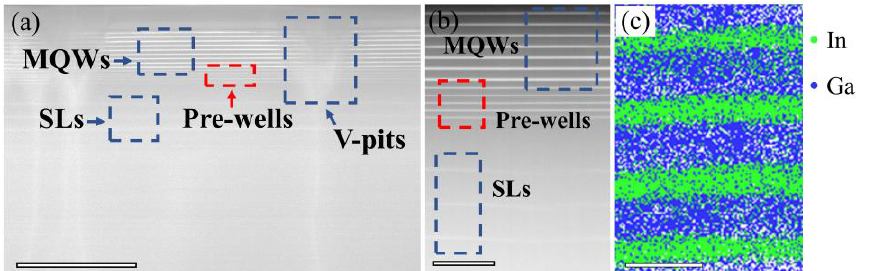
Figure 2. ( a , b ) Cross-sectional TEM images of epitaxial structure for LED II. ( c ) Reconstructed atom map of MQWs in LED II. Scale bars, 500 nm ( a ), 100 nm ( b ), 18 nm ( c ).